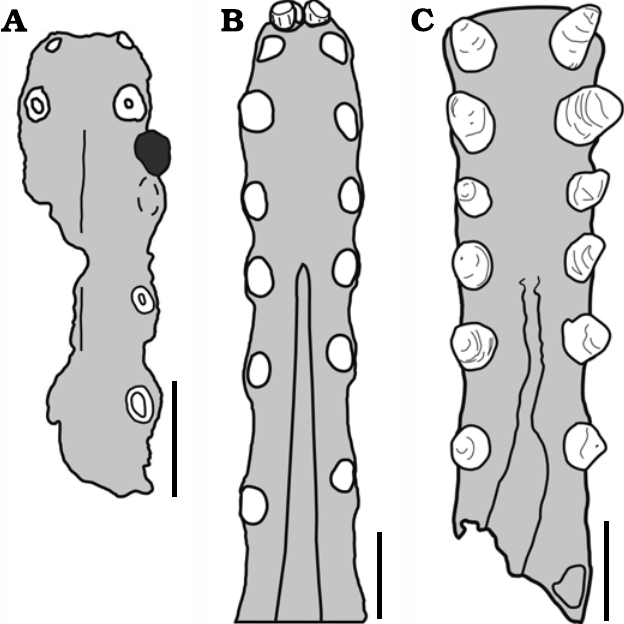
Fig. 12. Tropeognathinae anterior comparative plate. Palates in occlusal views. A . Ferrodraco lentoni . B . Tropeognathus mesembrinus ; black area in A represents a lower tooth; dashed line represents the weathered contour of the 3rd alveoli (see Pentland et al. 2019 for further details). C . Siroccopteryx moroc censis . Scale bars 20 mm. Drawings by